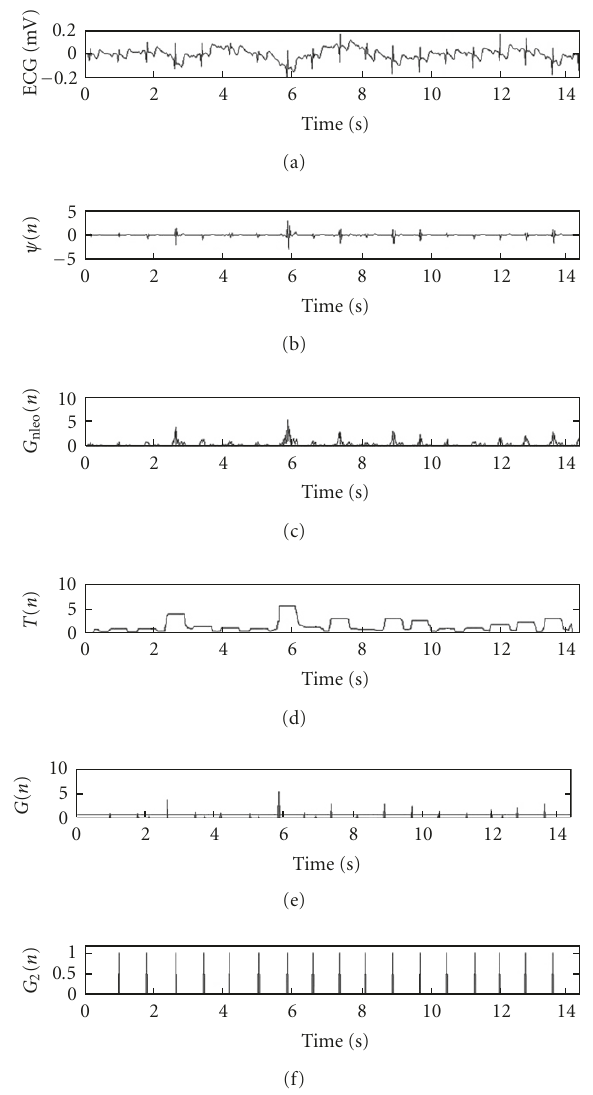
Figure 3: Generation of a trigger from the ECG: application to a real ECG channel (see main text for details on the signals shown).